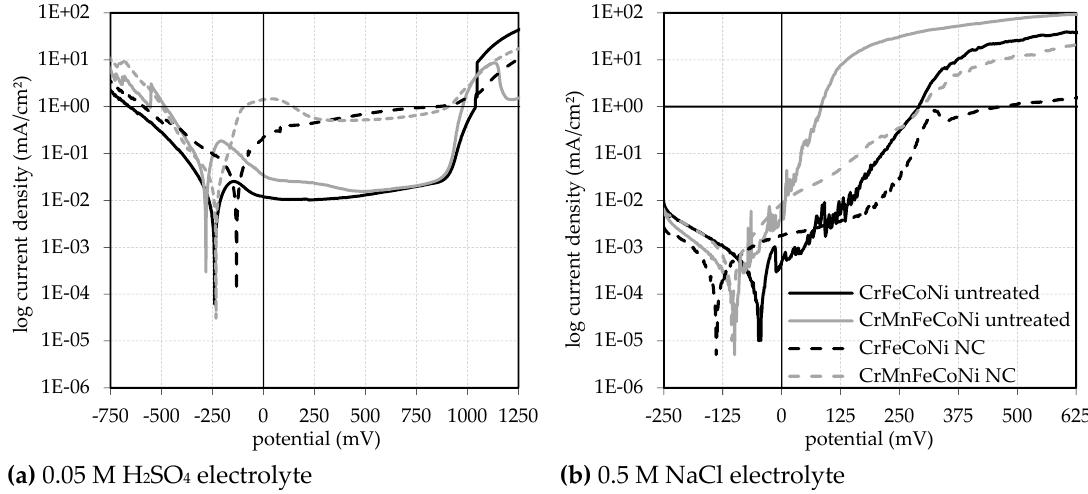
Figure 6. Current-density potential curves of CrFeCoNi and CrMnFeCoNi in as-cast and nitrocarburised state tested with different electrolytes.